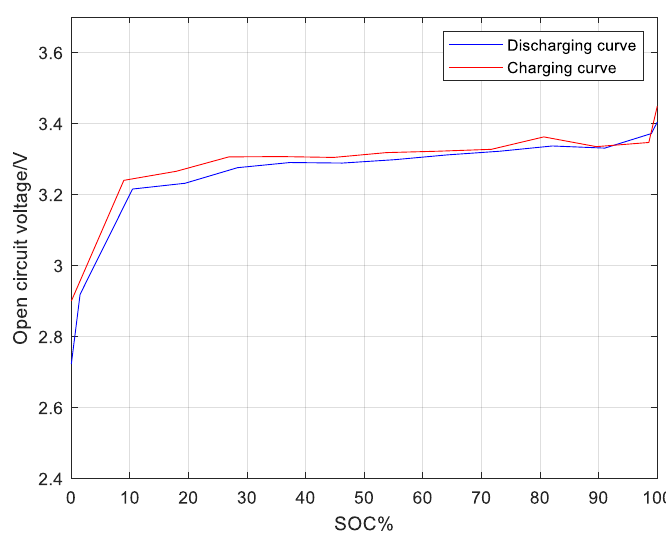
Figure 6. OCV-SOC relationship curve.